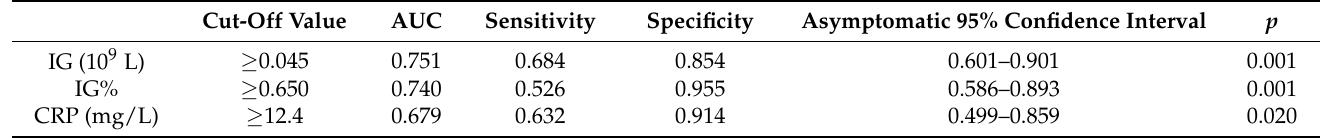
Table 4. Determination of cut-off points in hematological parameters for the diagnosis of SARS-CoV-2 infection in patients presenting with dyspeptic complaints.